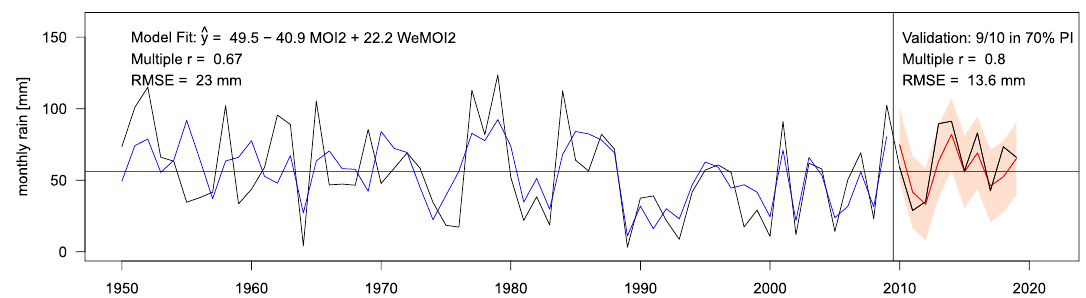
Table 2. Best subset regression for seven countries along the Balkan coast in January, ordered north to south. Shown are the estimated coefficients in the regression equation the modelled rainfall and X 1 , . . . , X 5 the five atmospheric indices, fitted to the data of the years 1950–2009 ("fit sample", see Methods). The slash indicates that the respective index X j was dispensable according to the best subset criterion. The last two columns show the correlation between predicted and observed rainfall in the fit sample (1950–2009) and the validation sample (2010–2019).